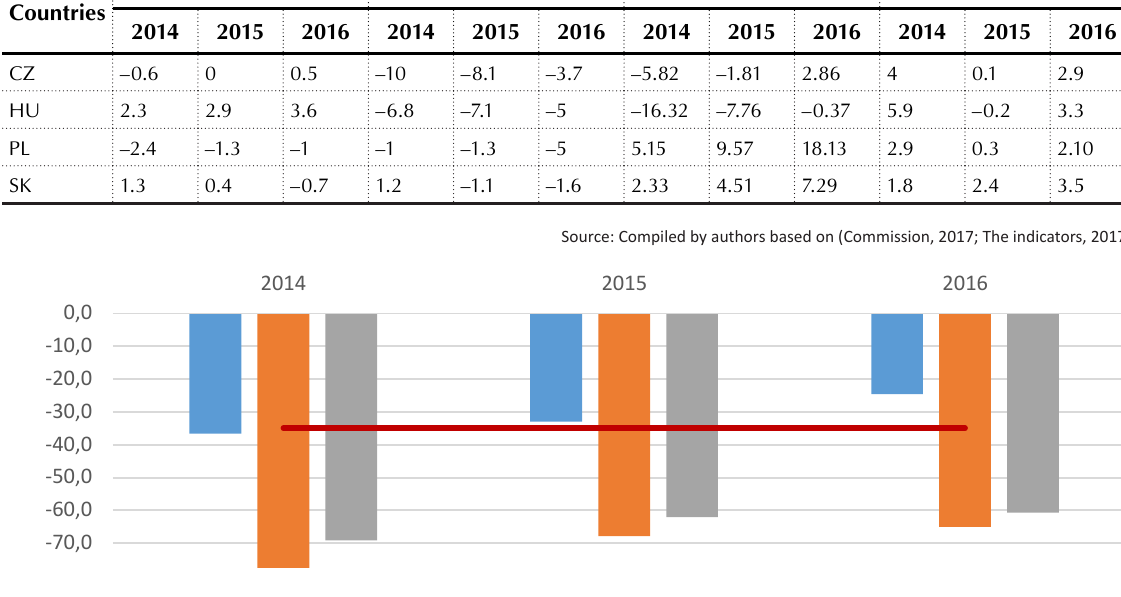
Figure 3. Net international investment position as percent of GDP of the Visegrad Countries, 2014–2016